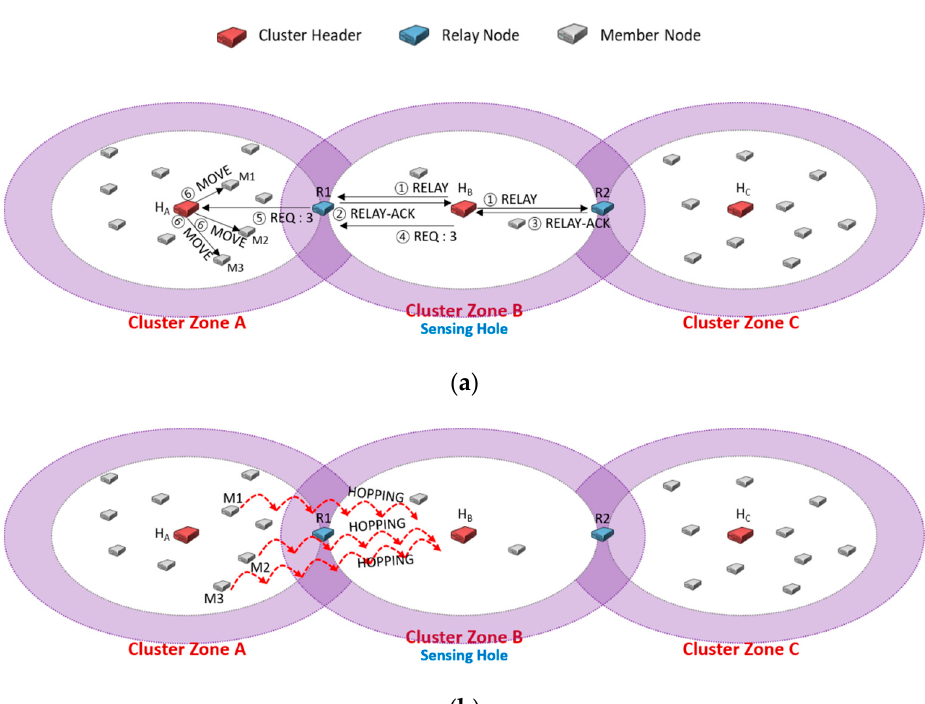
Figure 3. An example of the problem that the moved sensor nodes are relocated near the header of the sensing hole, H B .